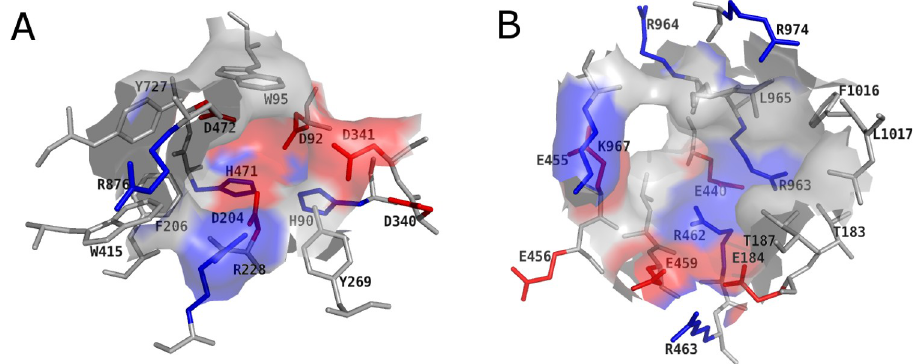
Fig 2. Colour-coded surface generated for the active site (A) and the identified pocket (B). Acidic and basic residues are coloured red and blue, respectively.